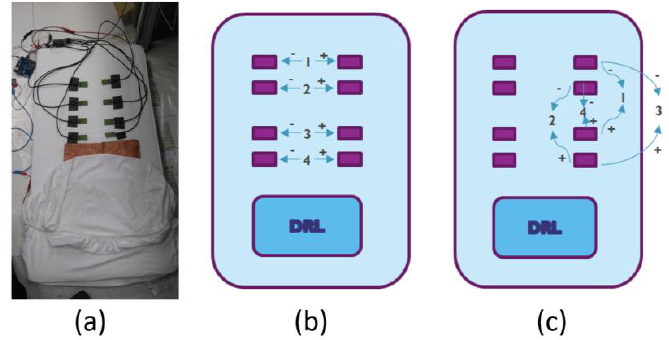
Figure 1. Mattress implementation of the multi-channel ccECG acquisition system and configuration for the different subject positions in the mattress. In ( a ) the system integrated in a mattress, before being covered with a cotton bed sheet; in ( b ) the electrode configuration for the four channels when recording signals from subjects lying on their back; in ( c ) electrode configuration for the four channels when recording signals from subjects lying on their left side; configuration for subjects lying on their right side is a vertically mirrored version of ( c ).